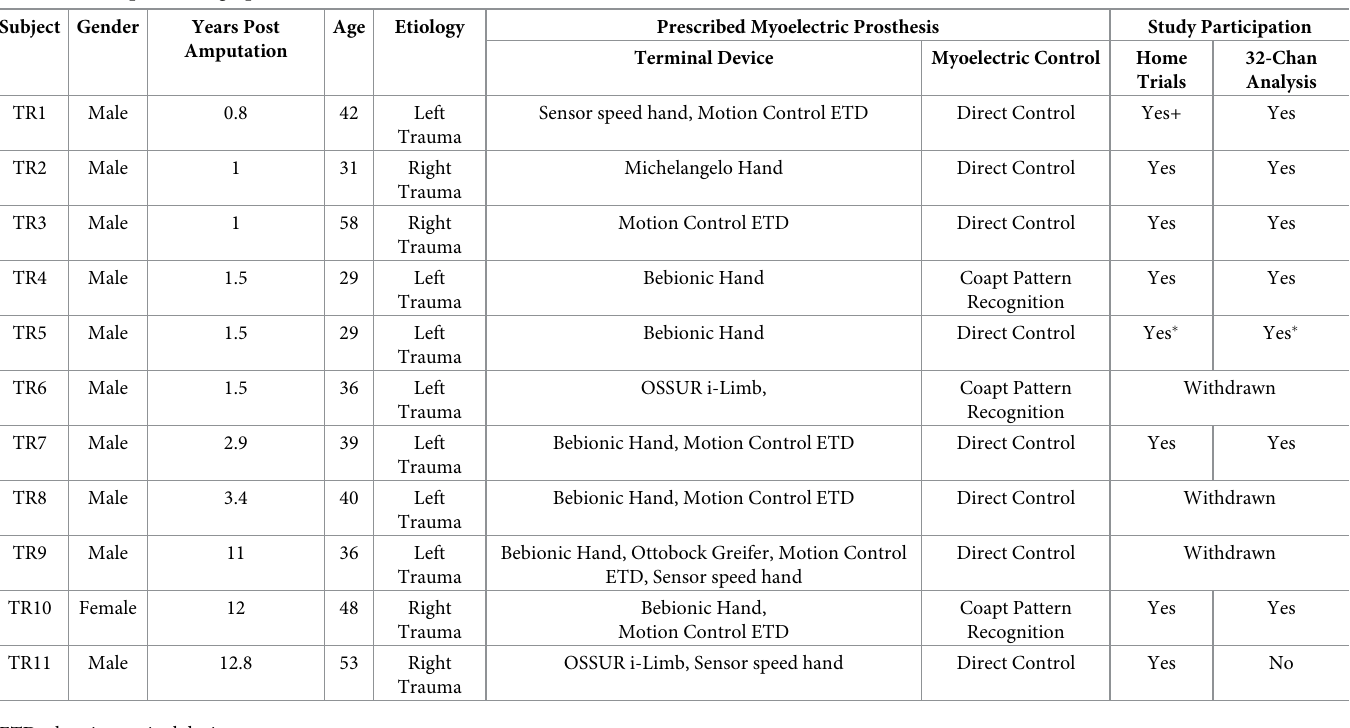
Table 1. Participant